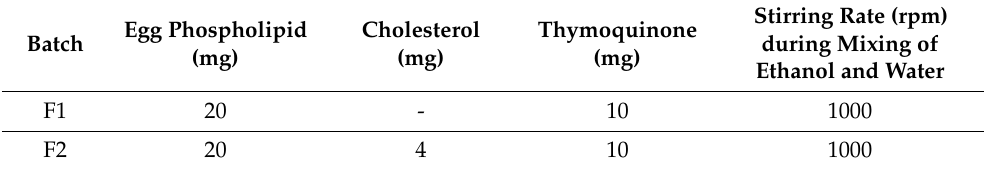
Table 4. Formulation attributes used for the preparation of liposomal drug-delivery system of